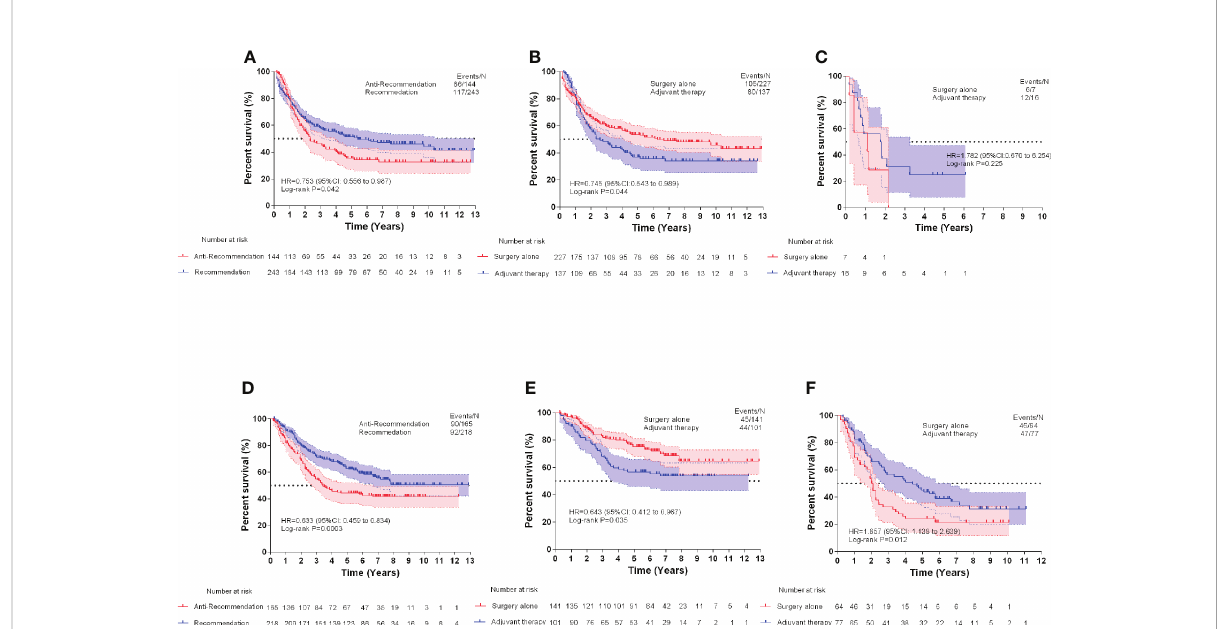
FIGURE 4 Esophageal cancer-speci fi c survival comparisons of Surveillance, Epidemiology, and End Results (SEER) test dataset (A) , SEER surgery alone recommendation test dataset (B) , and SEER adjuvant therapy recommendation test dataset (C) . Esophageal cancer-speci fi c survival comparisons of CHINA test dataset (D) , CHINA surgery alone recommendation test dataset (E) , and CHINA adjuvant therapy recommendation test dataset (F) .